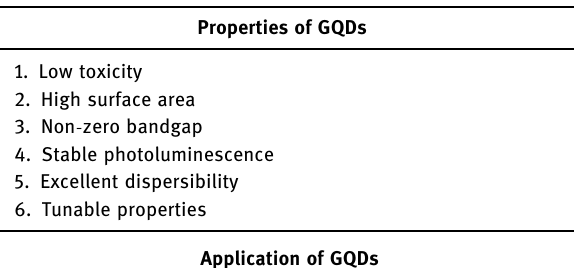
Table 1: Some of the substantial applications and properties of